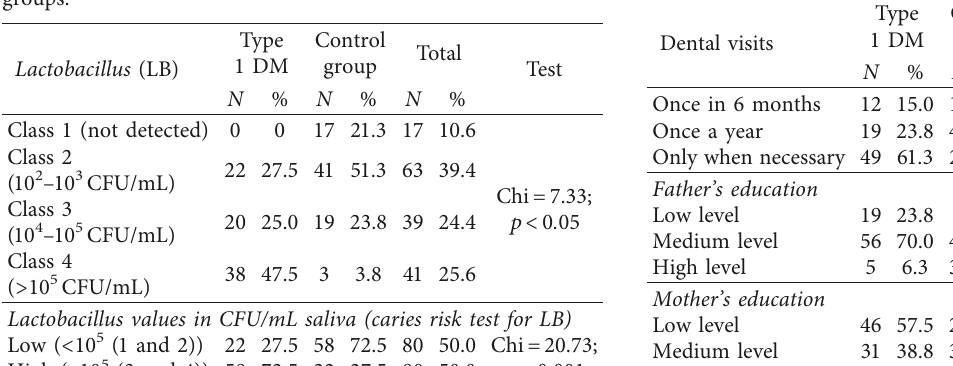
Table 4: General and specific distribution of Lactobacillus between groups.